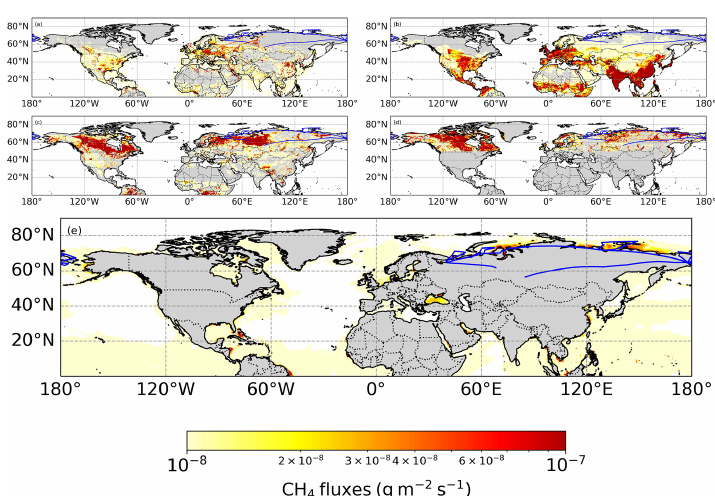
Figure B1. (a) Graphical representation of CH 4 fluxes due to fossil fuel exploitation as reported in Appendix Table A1 by EDGAR invento- ries. The trajectory of the campaign is represented by the blue line. (b) Same as (a) for agriculture by EDGAR. (c) Same as (a) for wetlands by ORCHIDEE. (d) Same as (a) for freshwater by bLake4Me and GLWD. (e) Same as (a) for oceans as described in Weber et al.